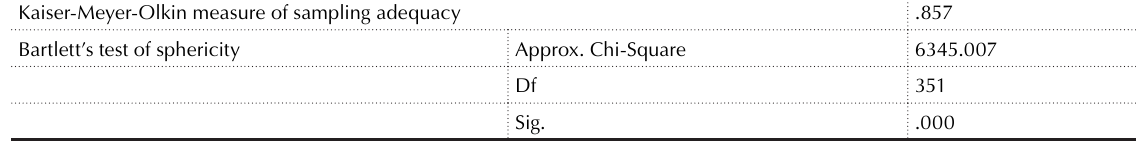
Table 2. KMO and Bartlett’s test